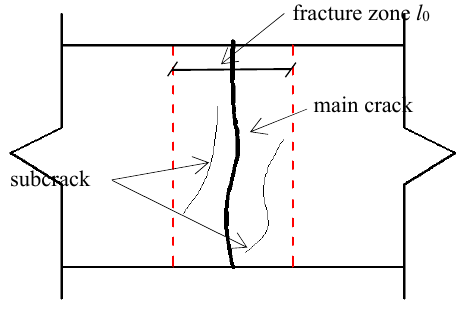
Figure 15. The schematic diagram of fracture zone.